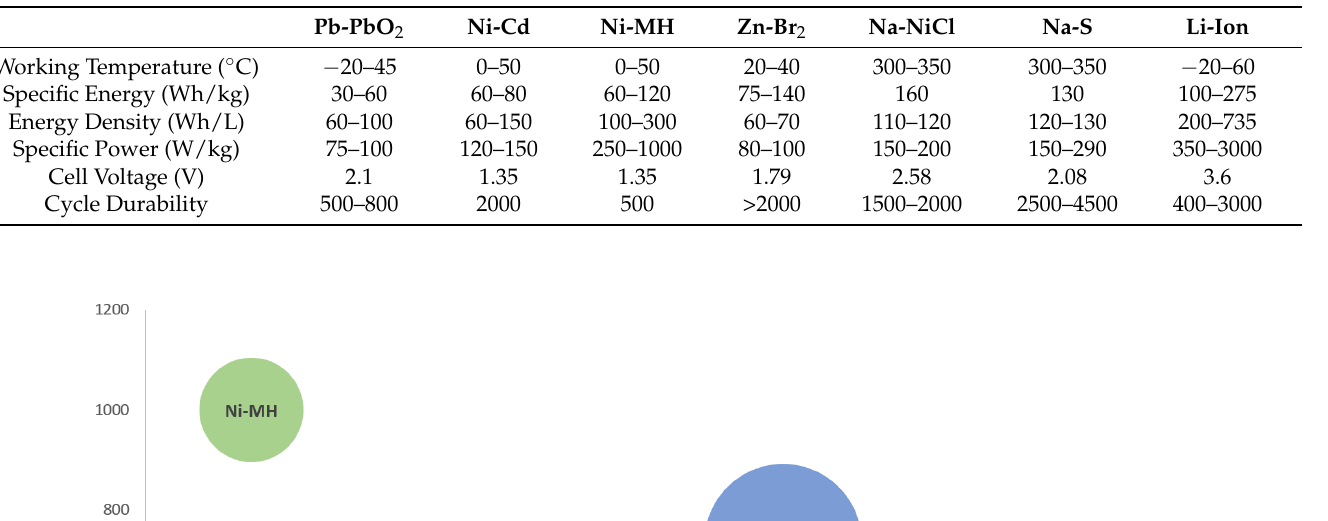
Table 3. Characteristics of EV batteries [35–41].